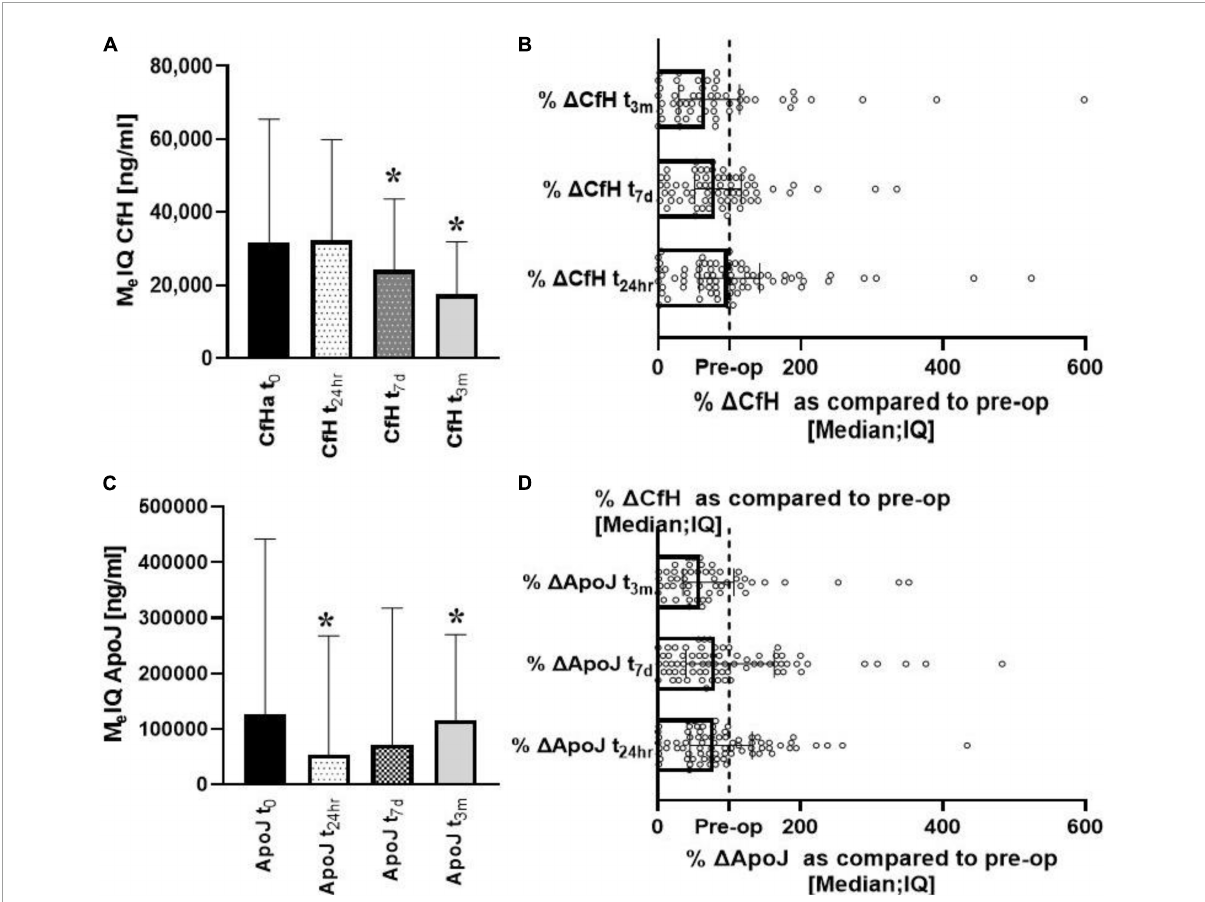
FIGURE2 Longitudinal analysis of complement protective factors (CfH, ApoJ) after heart surgery. Progressive depletion of the CfH could be seen in the post-op period (A,B) . In contrast, ApoJ started to recover after initial depletion (C,D) . *Denotes the statistical significance of 0.05 or